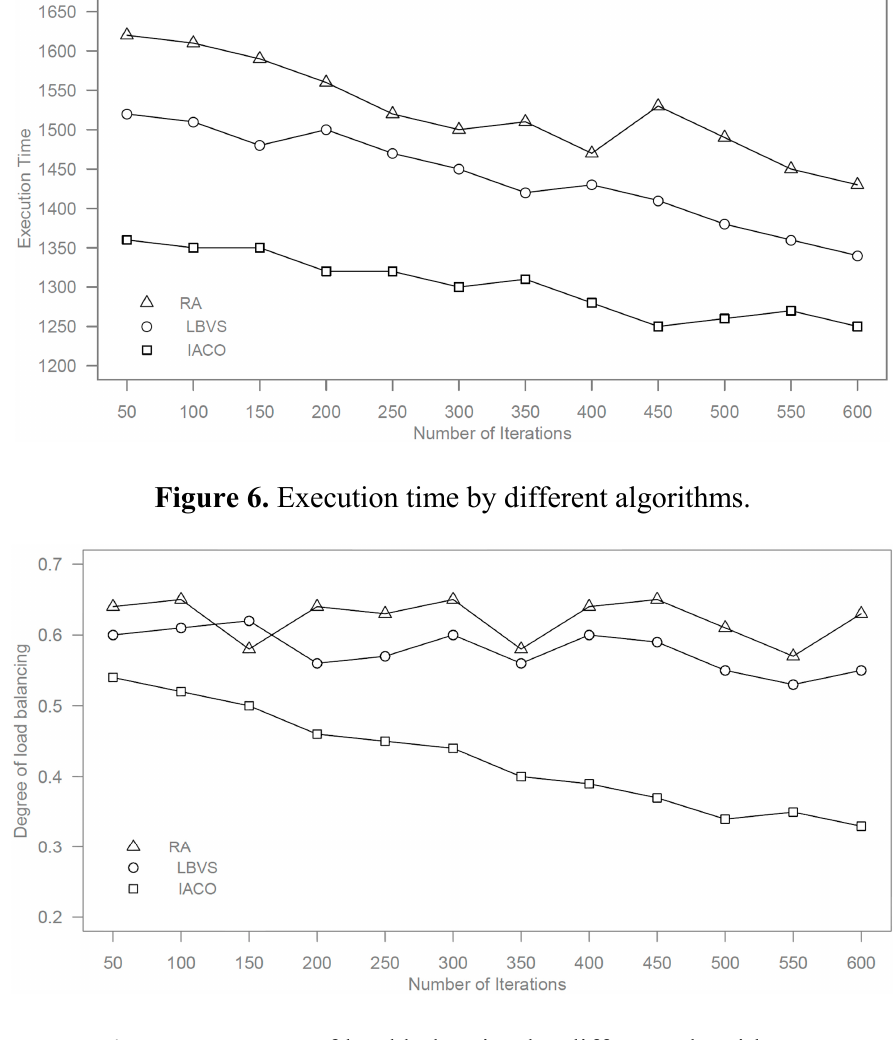
Figure 7. Degree of load balancing by different algorithms.